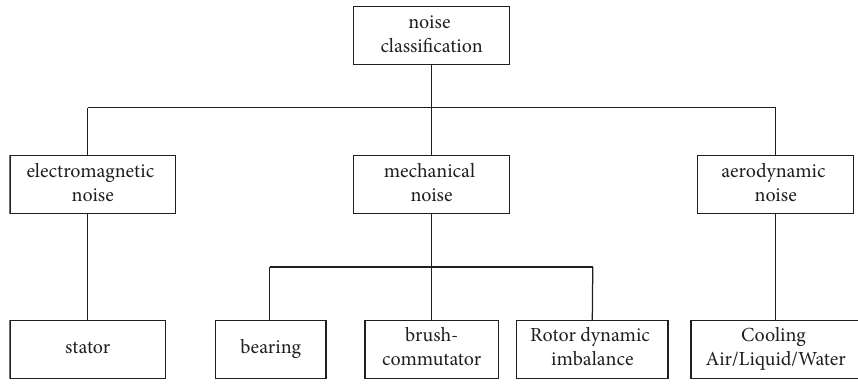
Figure 1: Motor noise